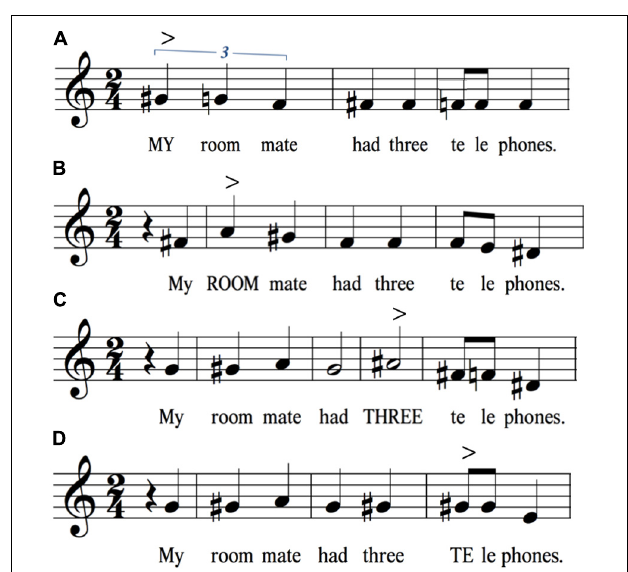
FIGURE 6 | Identical sentences but with narrow focus placed sequentially on different words. All four panels have the same string of words, but with narrow focus placed on either (A) my, (B) roommate, (C) three, or (D) telephone. Pitch rises are observed on the focus word in all instances but the last one. The symbol “ > ” signifies a point of focus or accent. For ease of presentation, only the stressed syllable of roommate and telephone is shown in block letters in the